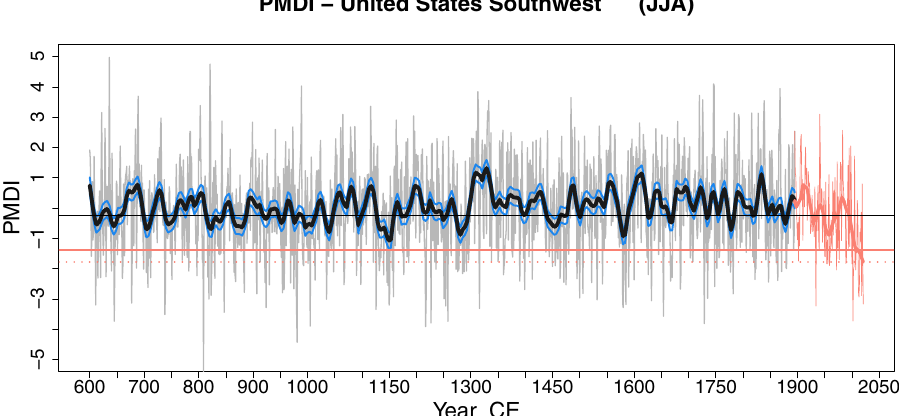
Fig. 6 Palmer Modi fi ed Drought Index extended to 600 CE. As Fig. 5b for RECON and INST periods, showing RECON extended to 600 CE (Methods). Solid horizontal salmon line indicates mean of lowess smooth for 2001 – 2021, dotted horizontal salmon line indicates value of lowess smooth for 2021. Note lower value of estimated 95% CI for 1149 smooth (driest year of mid-12th century drought) is 0.034 PMDI units less dry than lowess mean for 2001 – 2021.